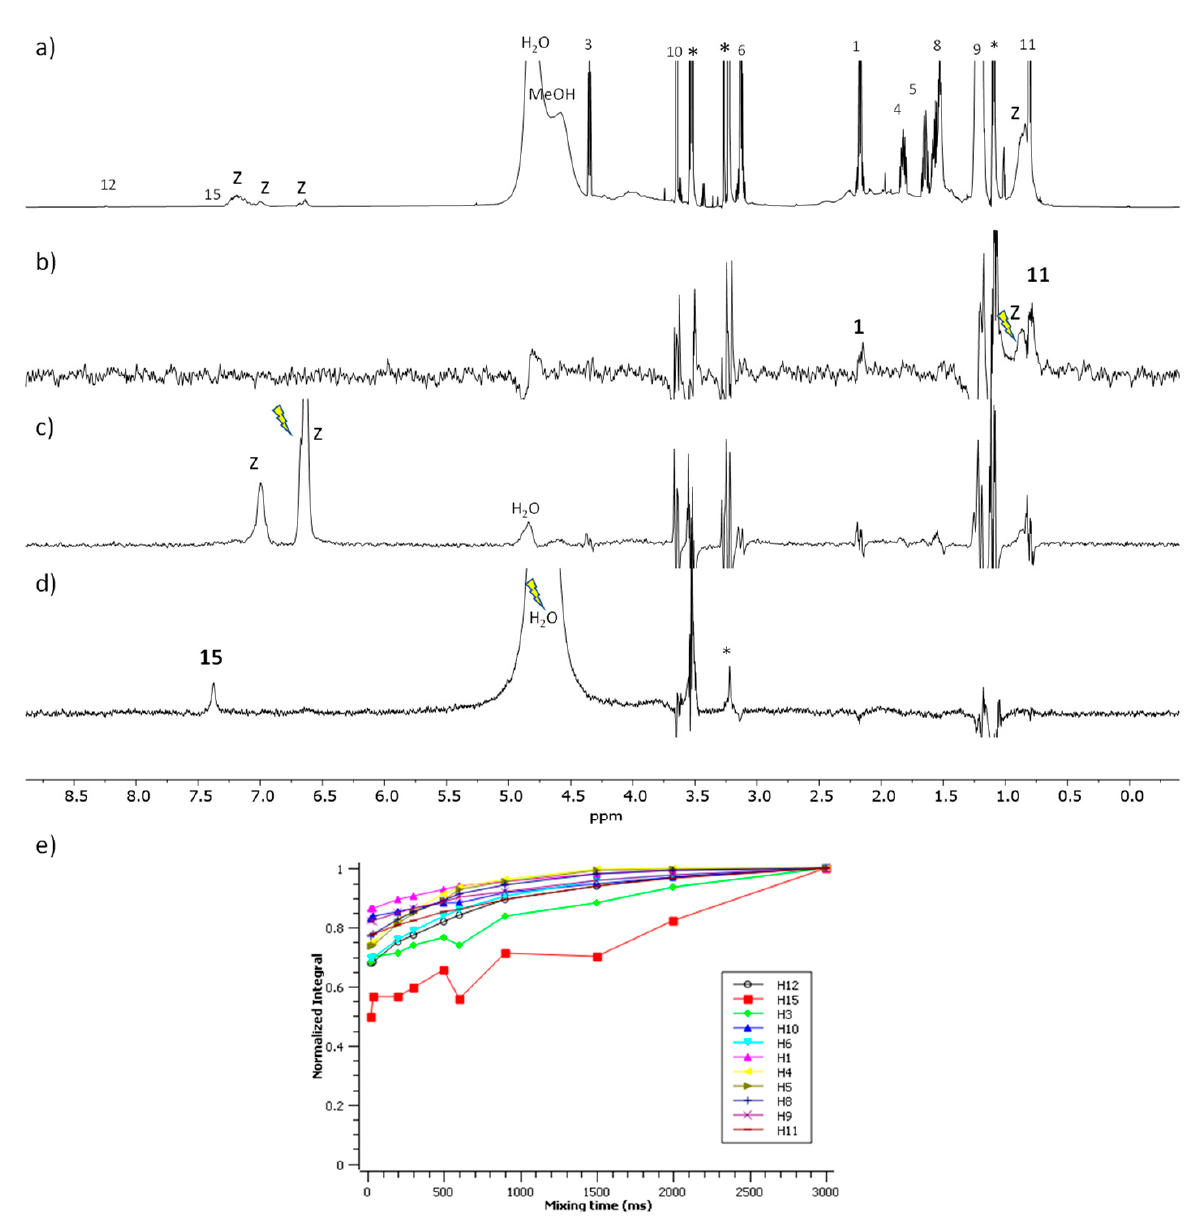
Figure 5. NMR binding interaction study between surfactant LAM and zein. ( a ) 1 H NMR ( b , c ) STD off-on with on-saturation applied over the signal of zein at ( b ) 0.82 ppm and ( c ) at 6.5 ppm ( d ) waterLOGSY spectrum with mixing time 500 ms. In ( b – d ) the signal selectively saturated or inverted is indicated with a ray symbol and the assignment of the relevant responses is indicated. Some impurities are denoted with asterisks. The letter z refers to zein signals. ( e ) Plot of the normalized signal intensity of the surfactant protons as a function of mixing time of the NOE-exch spectra.